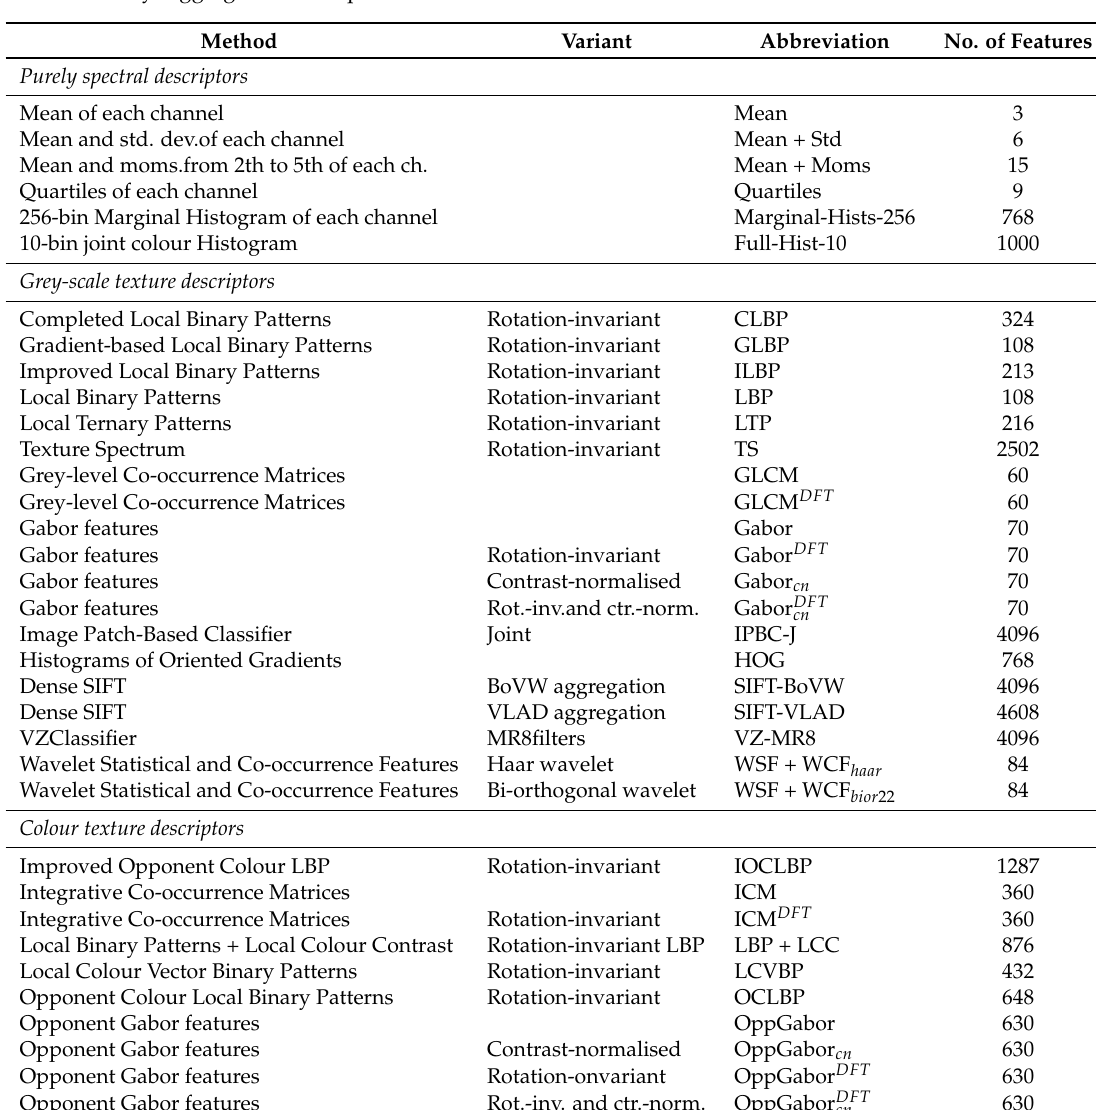
Table 2. Summary table of the hand-crafted image descriptors used in the experiments. VLAD, Vectors of Locally-Aggregated Descriptors. Method Variant Abbreviation No. of